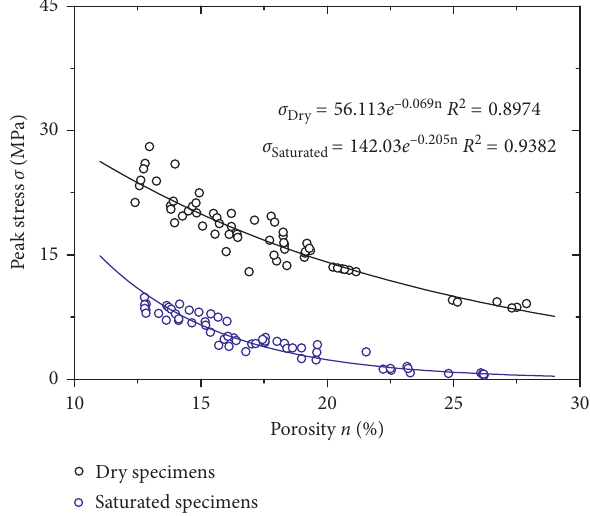
Figure 2: The relationship between porosity and